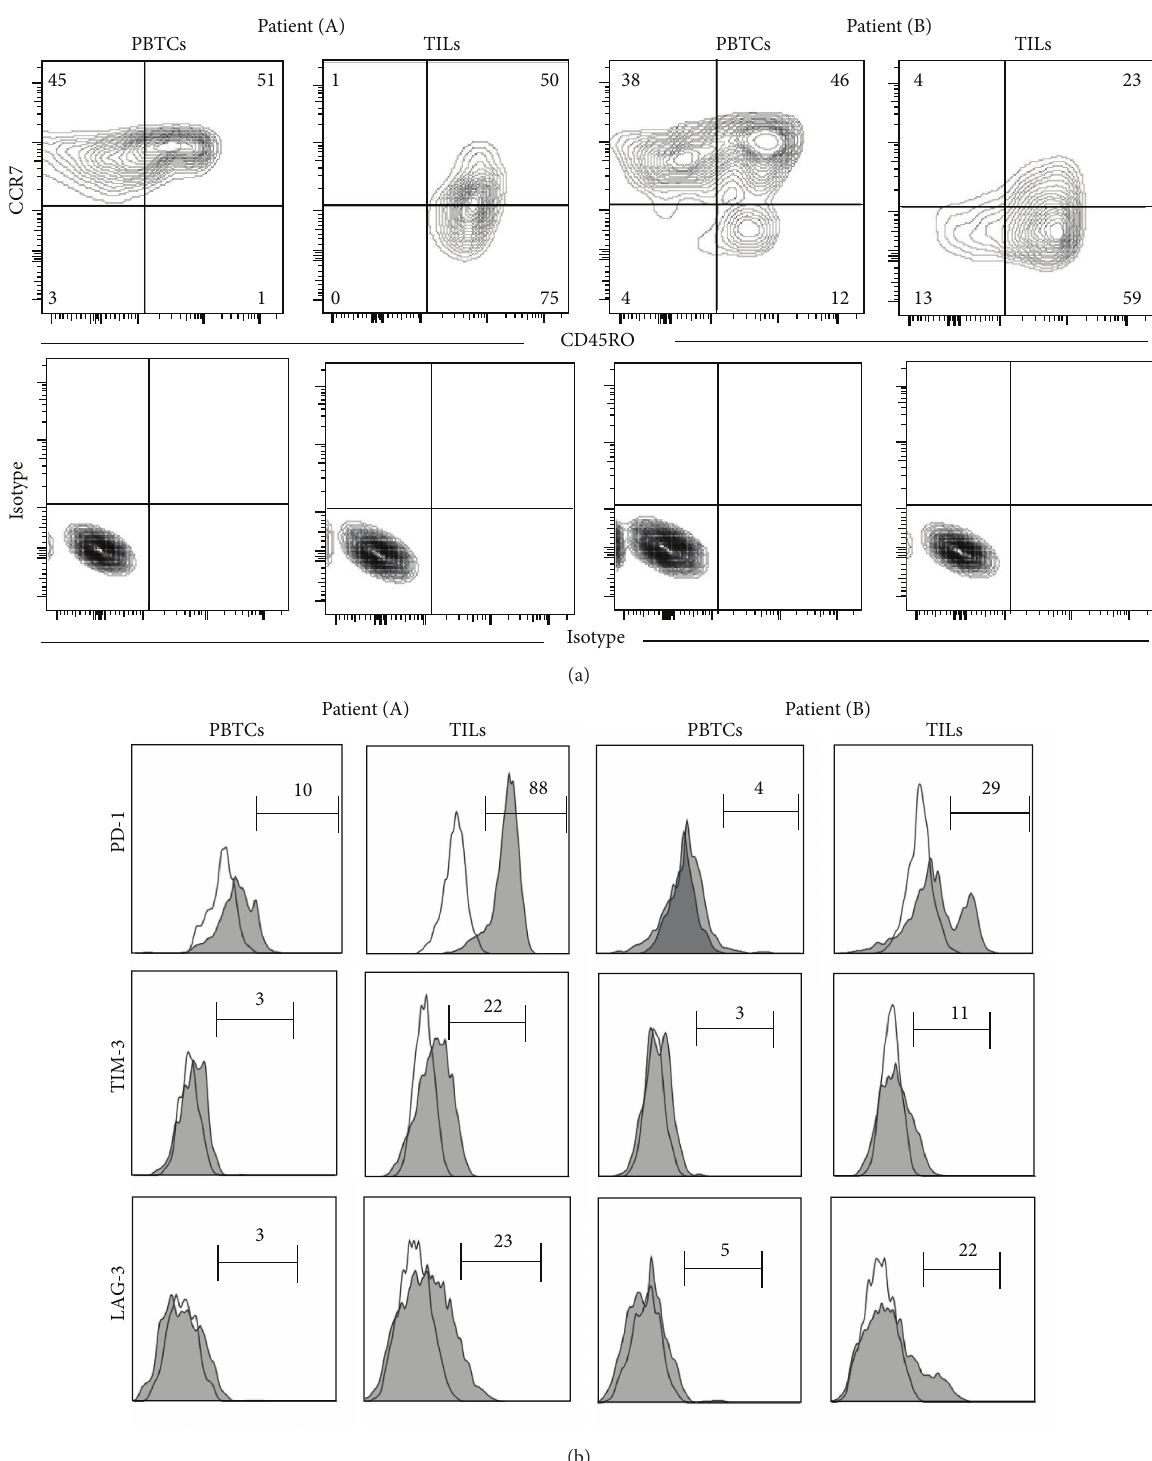
Figure 1: Freshly isolated CD8 + tumor-infiltrating lymphocytes (TILs) showed distinct phenotypical difference compared with CD8 +